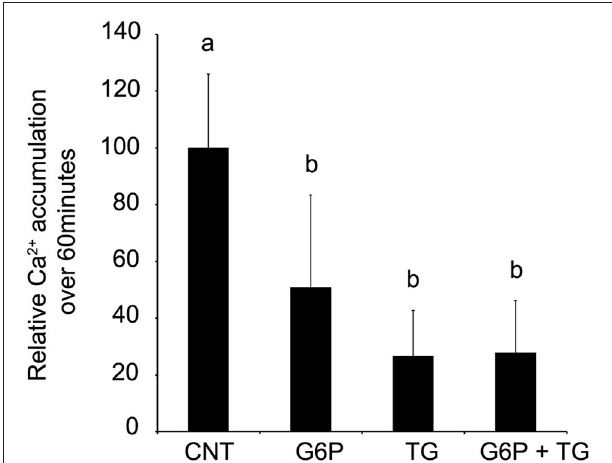
FIGURE 3 | After 60min of incubation, glucose-6-phosphate reduces the accumulation of 45 Ca 2 + in brain ER microsomes. Addition of glucose-6-phosphate (10mM), thapsigargin (1 µ M), or the two in combination significantly reduced ( p < 0 . 05) calcium accumulation. Individually, glucose-6-phosphate and thapsigargin reduced calcium accumulation by approximately 50%. When the two treatments were combined, there was no additive effect. Data are means ± SEM for n = 5. Each microsomal preparation contained a minimum of eight whole brains pooled together. ab Means with differing superscripts are significantly different, p < 0 . 05, while means that share superscripts are not significantly different.